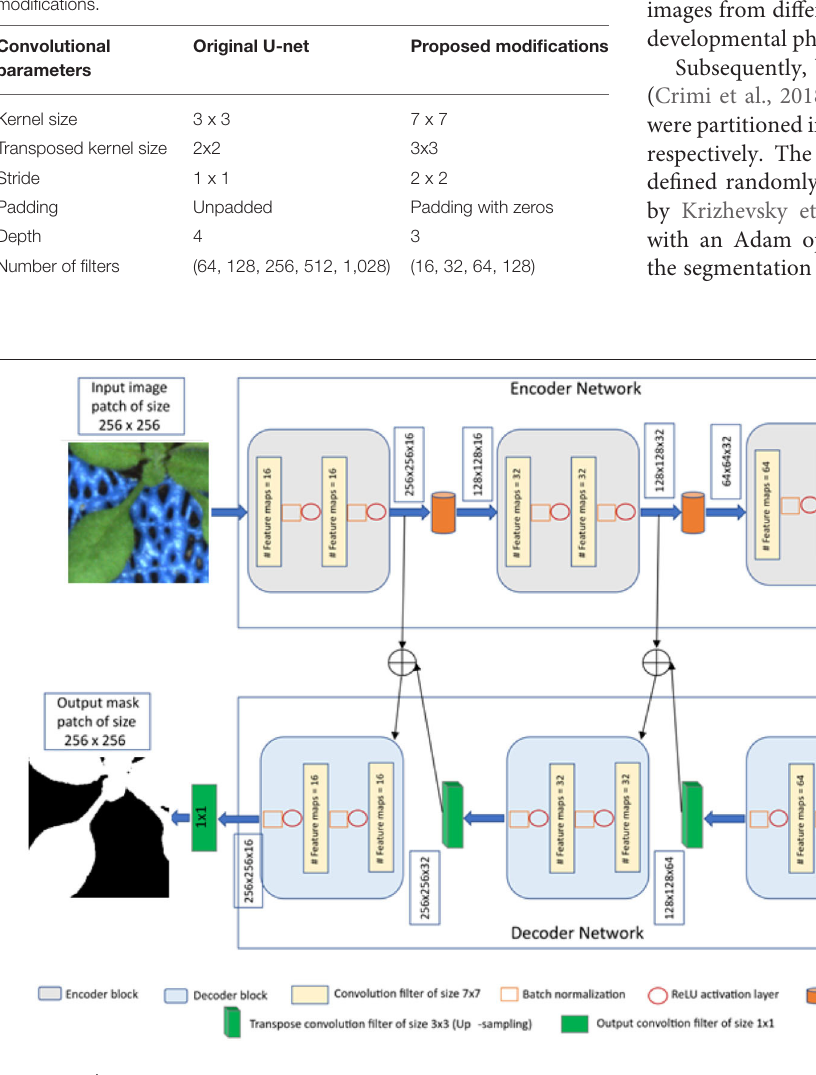
FIGURE 2 | The proposed U-net architecture for shoot image